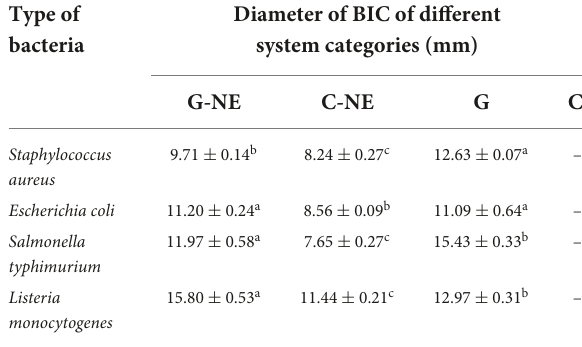
As shown in Figure 10D , L. monocytogenes in the control group reached the exponential growth phase at 4 h of incubation and entered the stable phase at 8 h. After G-NE treatment with 0.5 MIC, L. monocytogenes entered the exponential growth